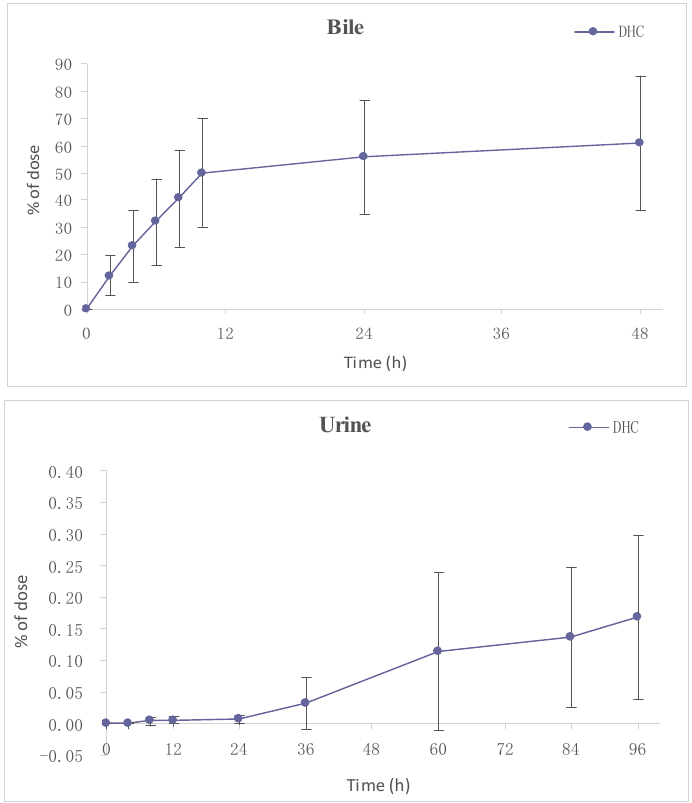
Figure 6. Cumulative amounts of DHC excreted in bile and urine after an oral dose of 97.5 mg/kg to